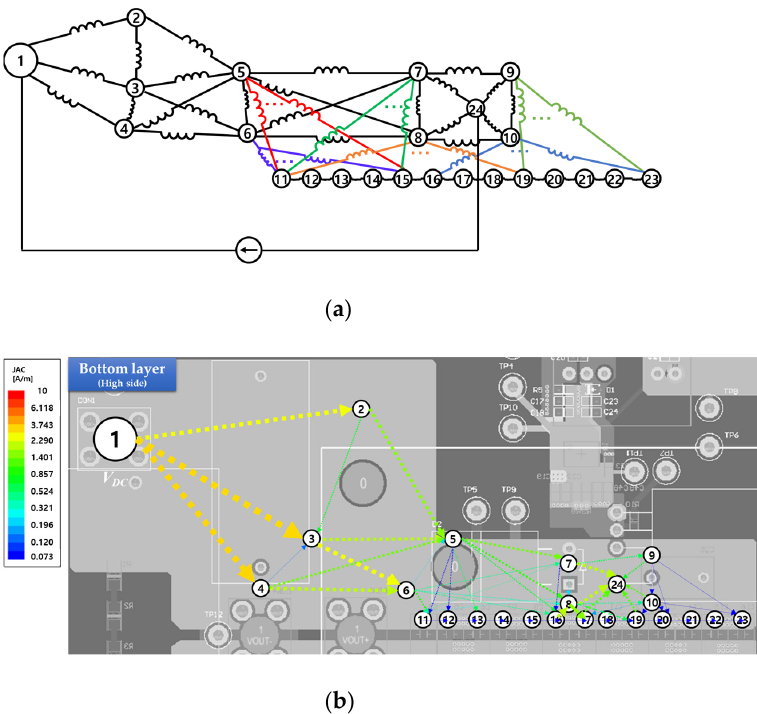
Figure 11. Q3D simulation results at bottom layer. ( a ) Current density of high side. ( b ) Current flow of high side. ( c ) Current density of low side. ( d ) Current flow of low side.